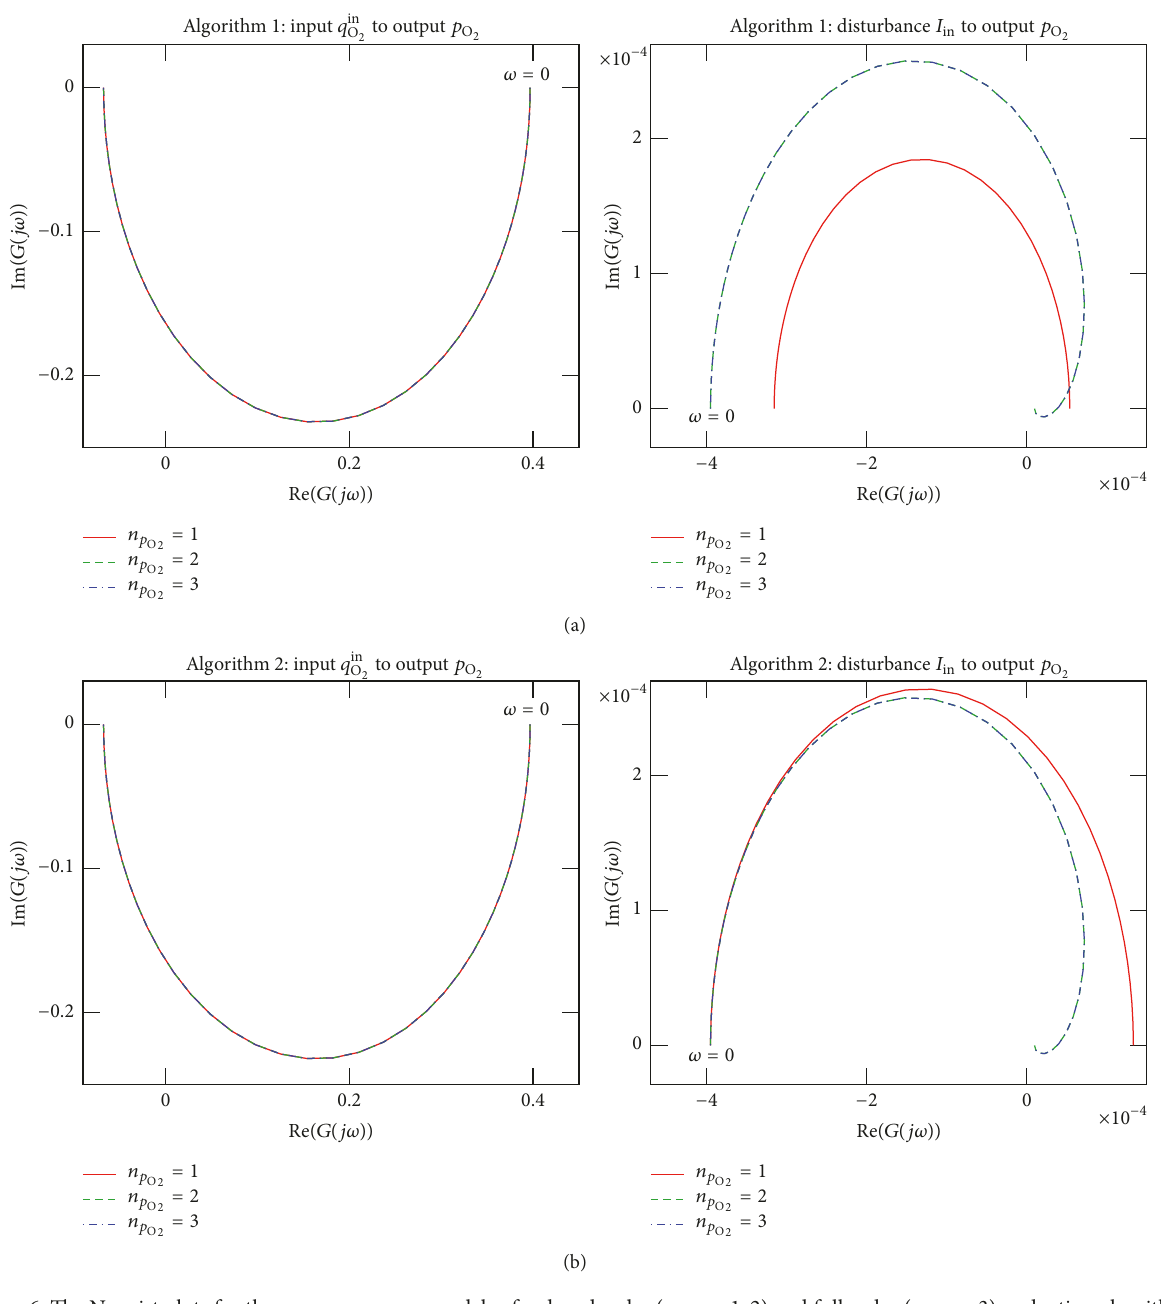
Figure 6: The Nyquist plots for the oxygen pressure models of reduced order ( 𝑛 𝑝 (a) and reduction algorithm 2